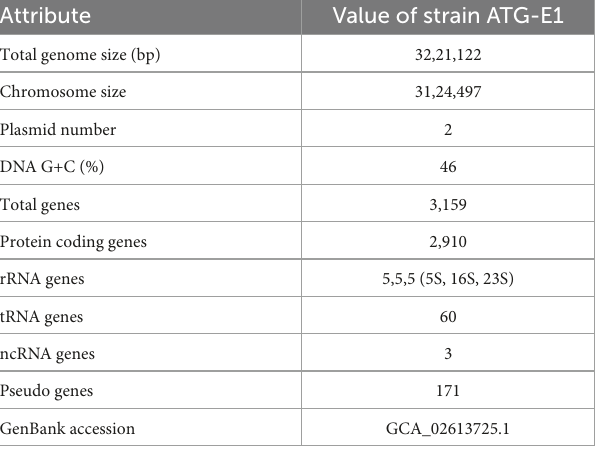
antibiotic resistance genes with ResFinder 4.1 ( Supplementary Datasheet 1, 2